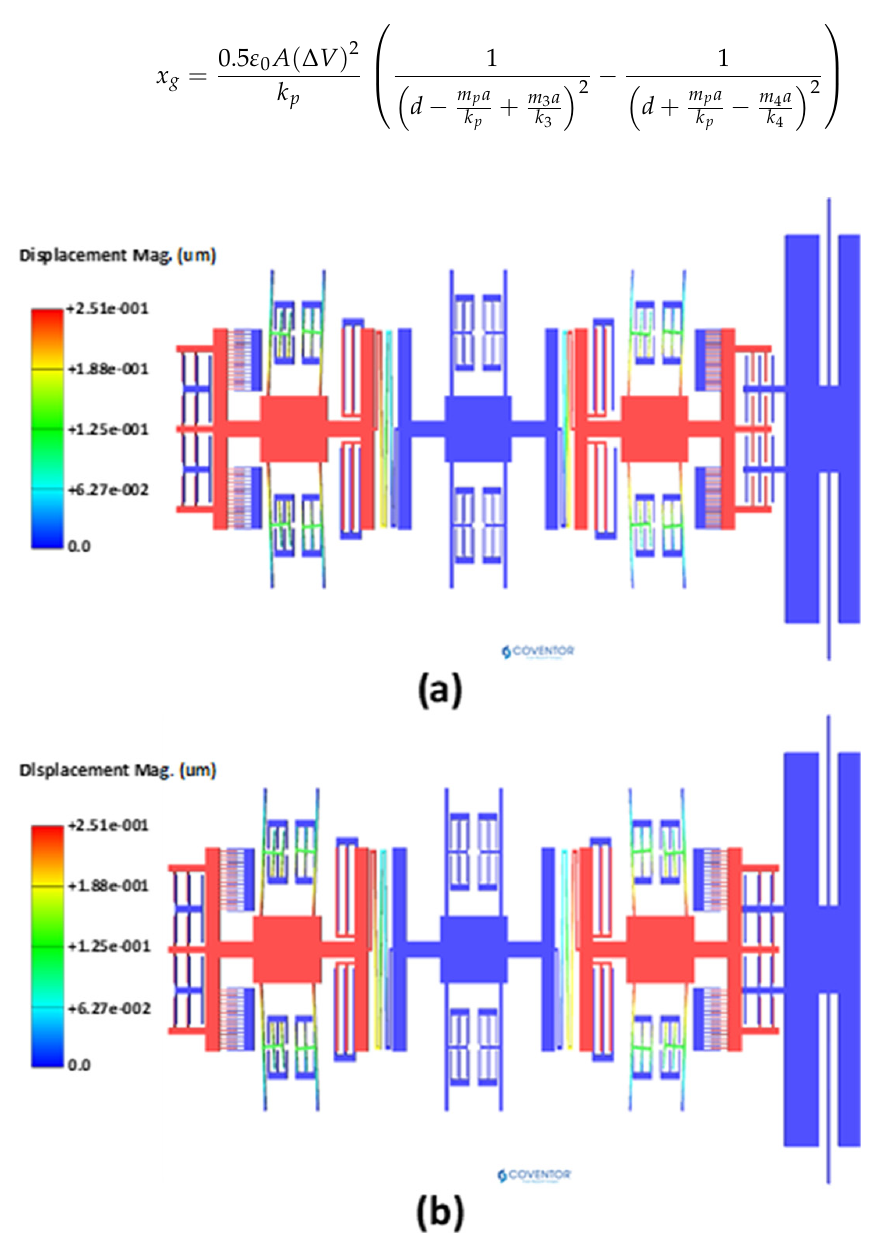
Figure 3. Natural frequency analysis for the MEMS accelerometer ( a ) in-phase mode (12,220 Hz) ( b ) out-of-phase mode (12,223.3 Hz).